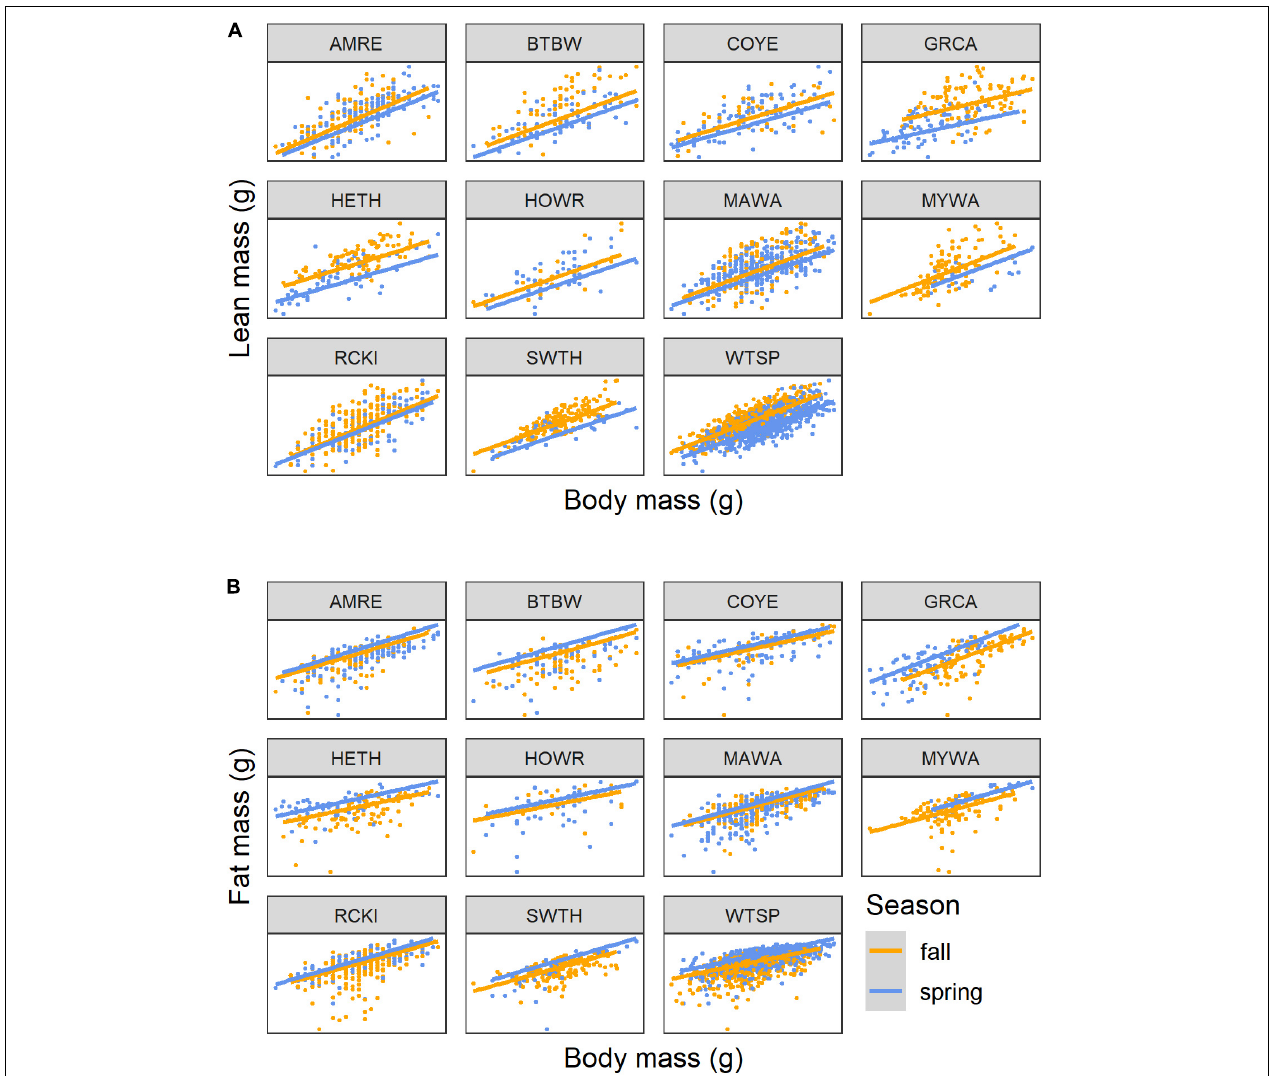
FIGURE 4 | Scaling of lean mass (A) and fat mass (B) with body mass for 11 species of songbirds stopping over at Long Point, Ontario, highlighting differences between seasons. The lines show the linear mixed model predictions for spring (blue) and autumn (orange) when year = 2009. Ranges of masses can be cross-referenced with Figure 3 . Species codes are defined in Table 1